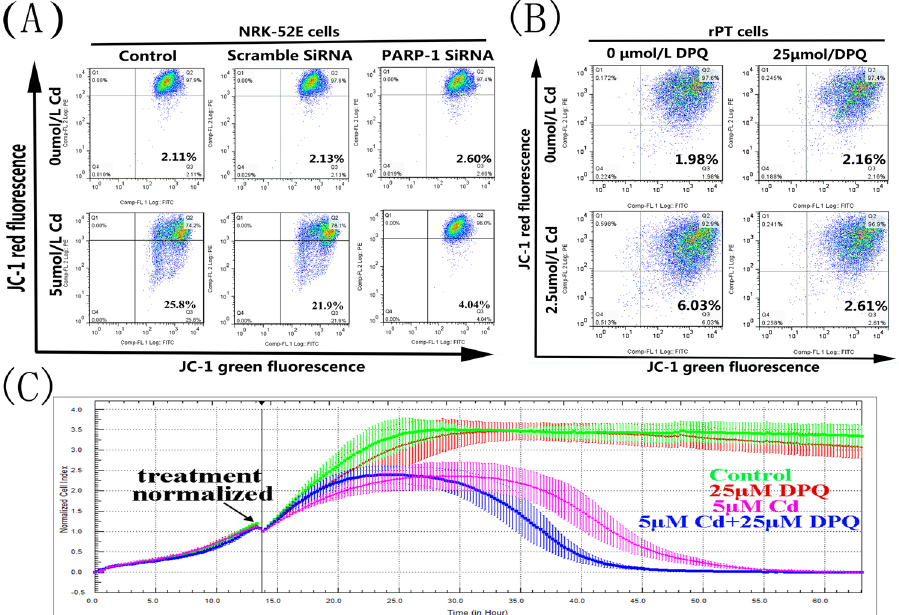
Figure 7. The effect of PARP-1 protein on mitochondrial membrane potential and proliferation of rat proximal tubular cells. ( A and B ) Flow cytometry analysis combined with JC-1 staining showed the decline in the mitochondrial membrane potential caused by Cd treatment for 12 hours in rat renal tubular epithelial cells, which was inhibited by PARP-1 gene knockout or PARP-1 inhibitor DPQ at 25 μ M. ( C ) Cell index for NRK-52E cells treated with 5 μ M Cd and 25 μ M DPQ as indicated. Results were normalized to the time of treatment and error bars indicate SD (n =